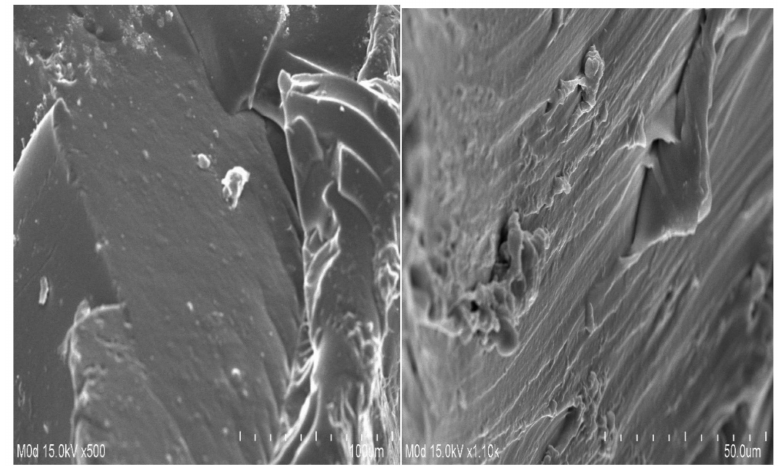
Figure 7. Surface morphology of SPSPAA